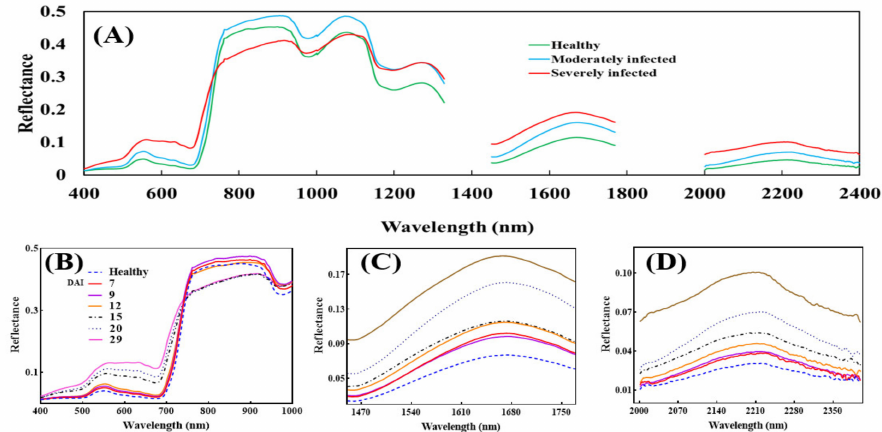
Figure 11. The averaged spectral signatures from two years of experiments. Healthy: reflectance at the day of inoculation; DAI: days after inoculation; ( A ) reflectance spectra at different disease infection severities; ( B ) 400–100 nm wavelength at different DAI; ( C ) 1451–1770 nm at different DAI; ( D ) 2000–2400 nm at different DAI (to interpret colored references in given figure legends, the reader is referred to consult the article’s web